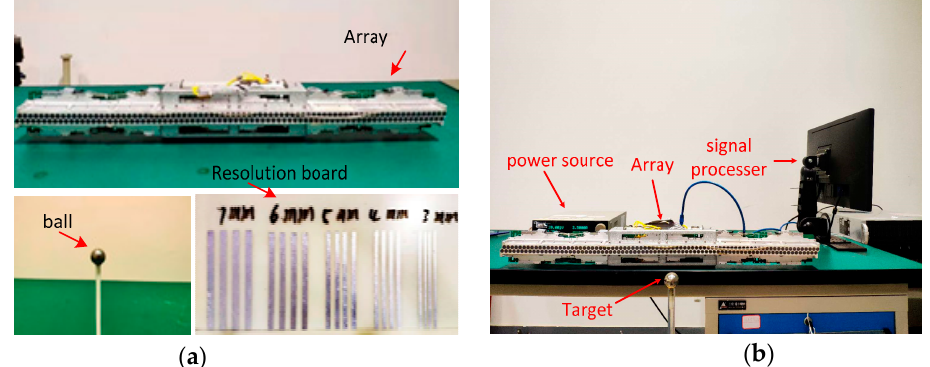
Figure 11. The array, targets and photo of measurements in experiments, ( a ) is array and targets; ( b ) is the experiment scene.